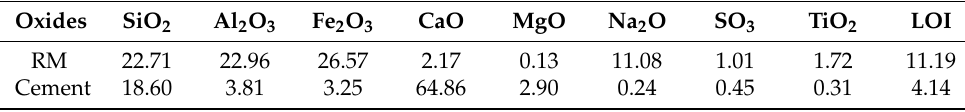
Table 1. The chemical constituents of RM and cement